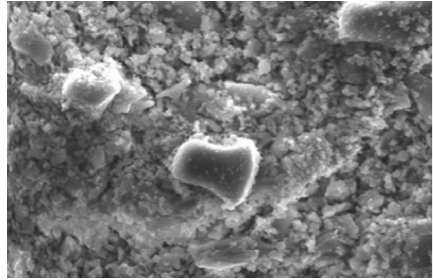
Figure 2: Morphology of bamboo leaf ash [25].